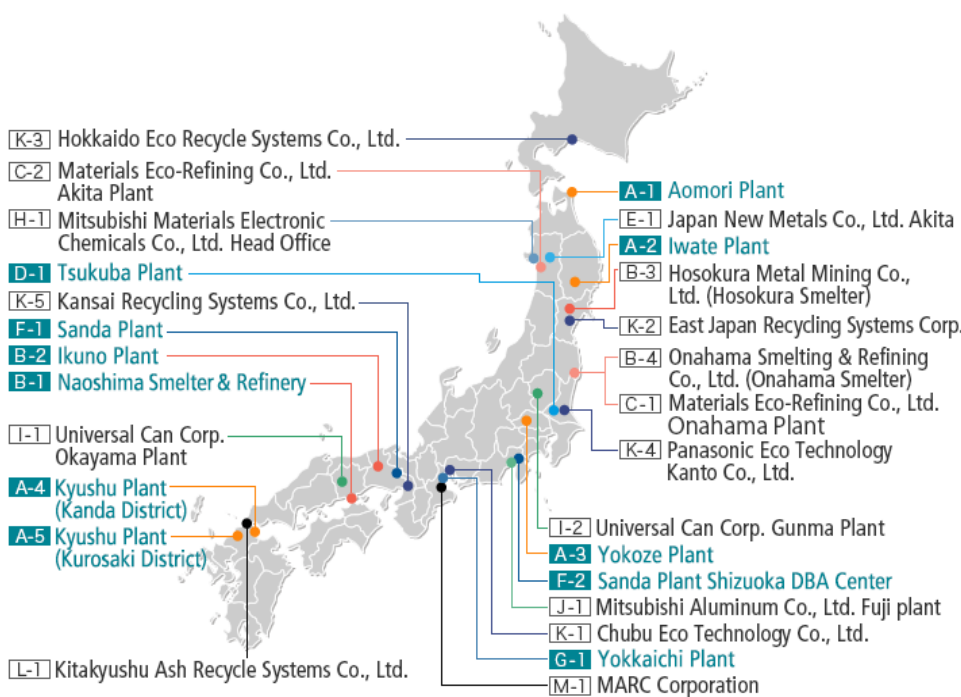
Figure 2: Mitsubishi Materials Group. The Resource Recycling Network